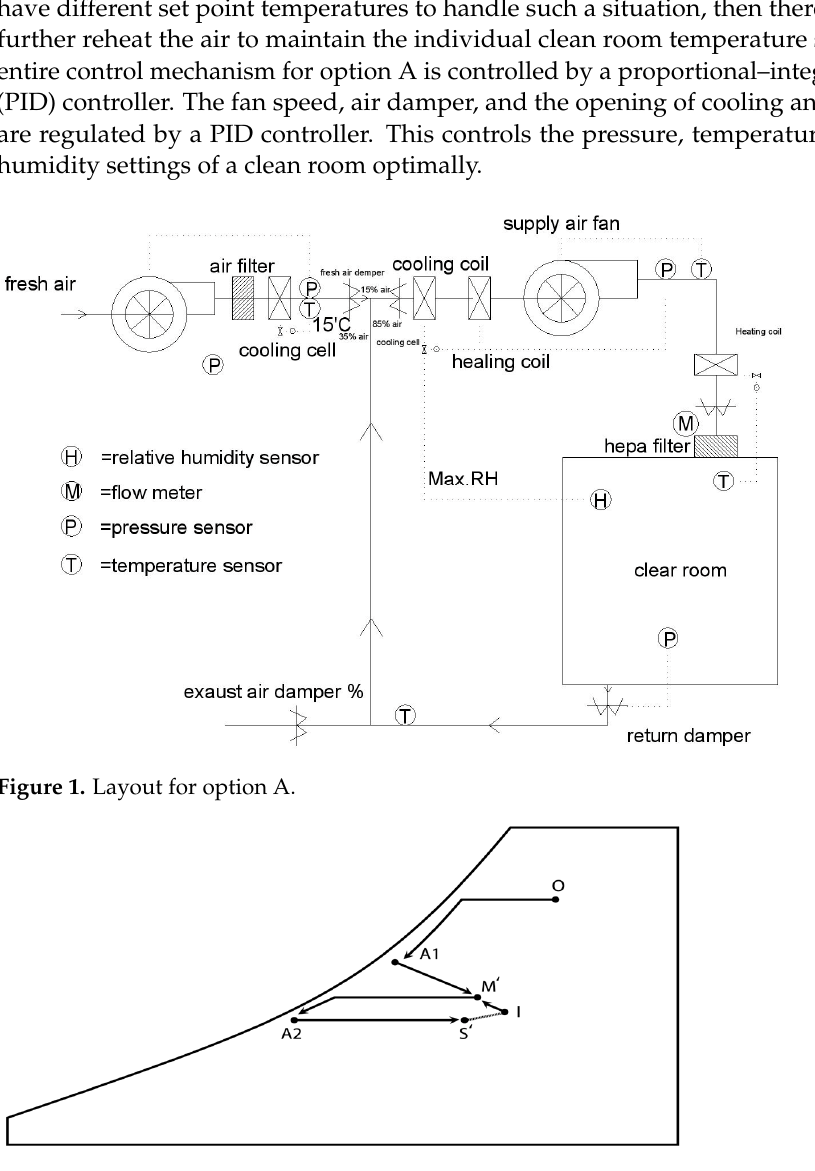
Figure 2. Psychometric chart for option A.